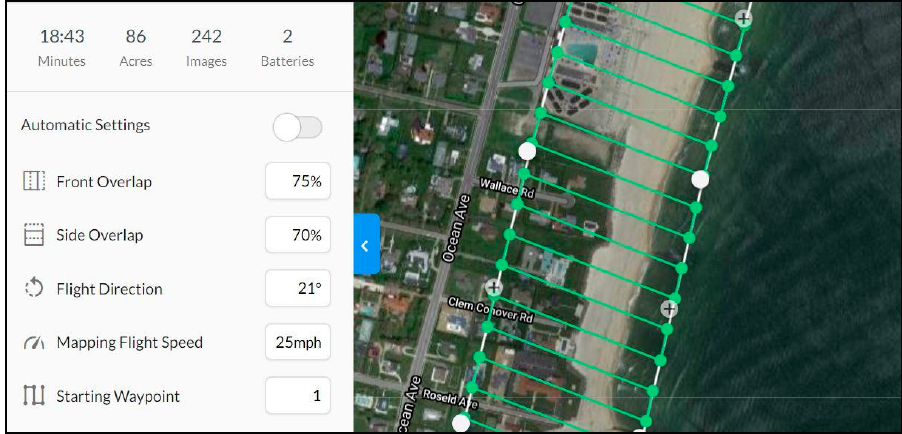
Figure 4. Example flight planning input in DroneDeploy Software.